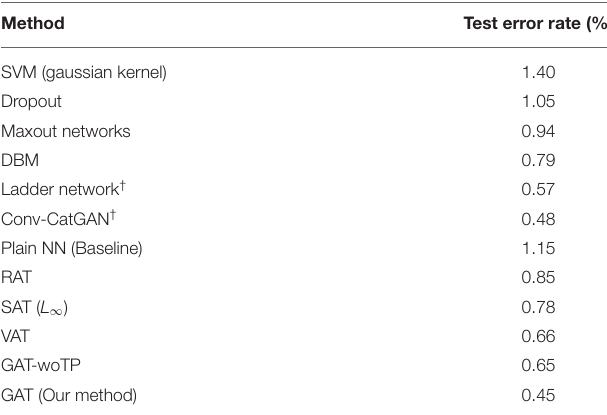
TABLE 1 | Test error rates of various regularization methods for supervised learning task on MNIST dataset.